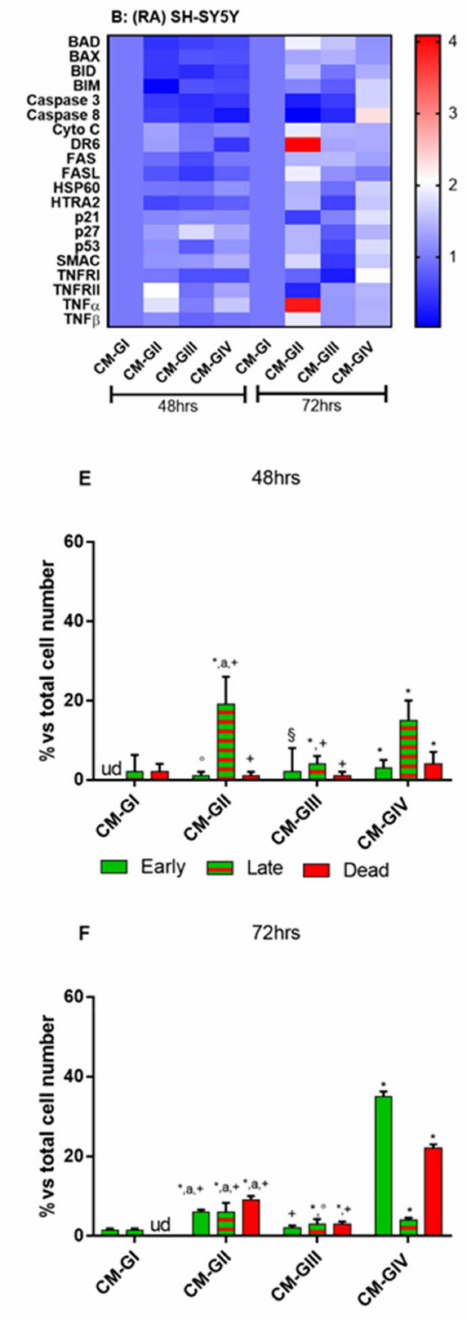
Figure 3. Apoptosis pathway analysis. Heat map of pro-apoptotic protein levels analyzed both in HTMCs ( A ) and RA-SH- SY5Ys ( B ). The color scale represents the value relating to pro-apoptotic protein levels in the various treatment groups. An Annexin V-FITC/PI-stained fluorescence microscope was used to evaluate the different stages of apoptosis in HTMC ( C , D ) and in RA-SH-SY5Y ( E , F ). The bar diagram shows early (green bars) and late (green/red bars) apoptosis and death cells (red bars) after 48 and 72 h of experimental procedures. * p < 0.001 vs. control cell group; a, #, +, ◦ p < 0.001; § p < 0.01 vs. treated cell group (Two-way ANOVA followed by Bonferroni